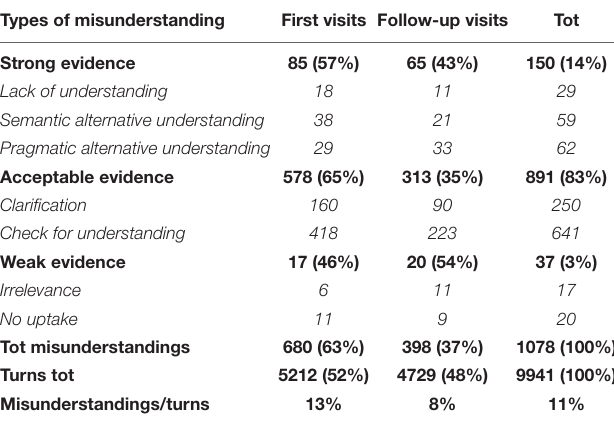
TABLE 3 | Frequency (n, %) of the different types of misunderstanding in first and follow-up visits.